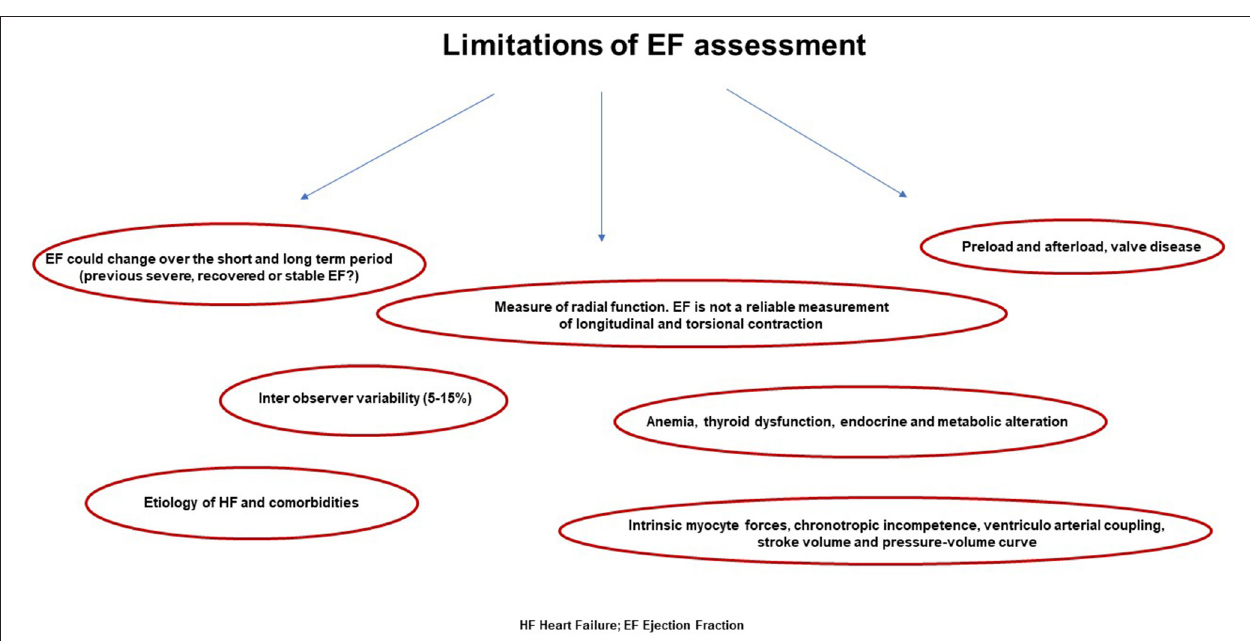
FIGURE 1 | The spectrum of patients with HF ranging from severe ejection fraction reduction to preserved function, according to baseline phenotype, disease time course, response to therapy, and loading conditions.